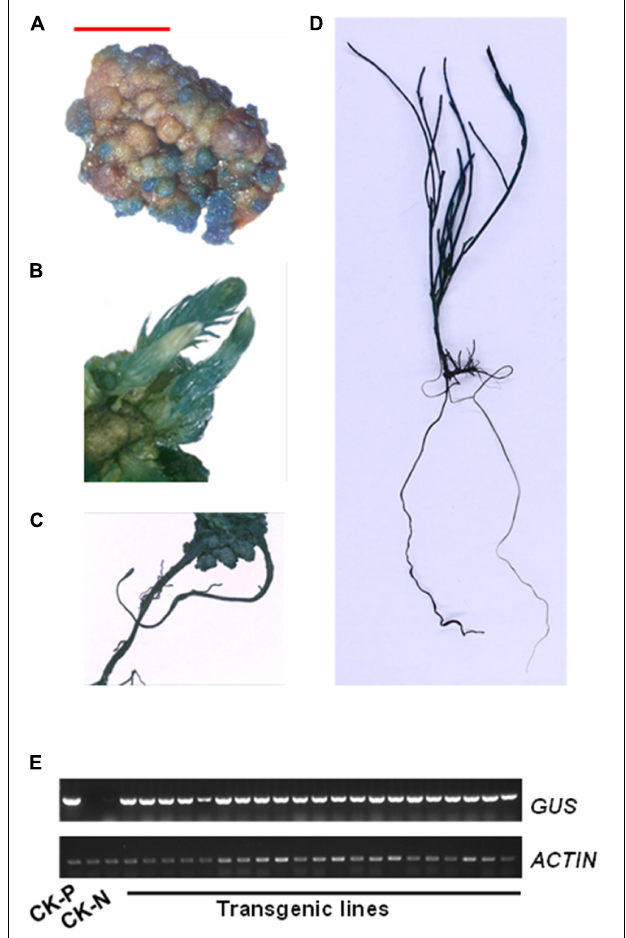
FIGURE 7 | β -Glucuronidase (GUS) expression in transgenic Casuarina equisetifolia plants. (A–D) GUS staining was observed in the (A) callus, (B) adventitious bud, (C) root, and (D) transgenic plantlet. (E) Analysis of GUS transcriptional levels in pCAMBIA1301 plasmid (P), non-transformed plants (N) and transgenic lines by RT-PCR